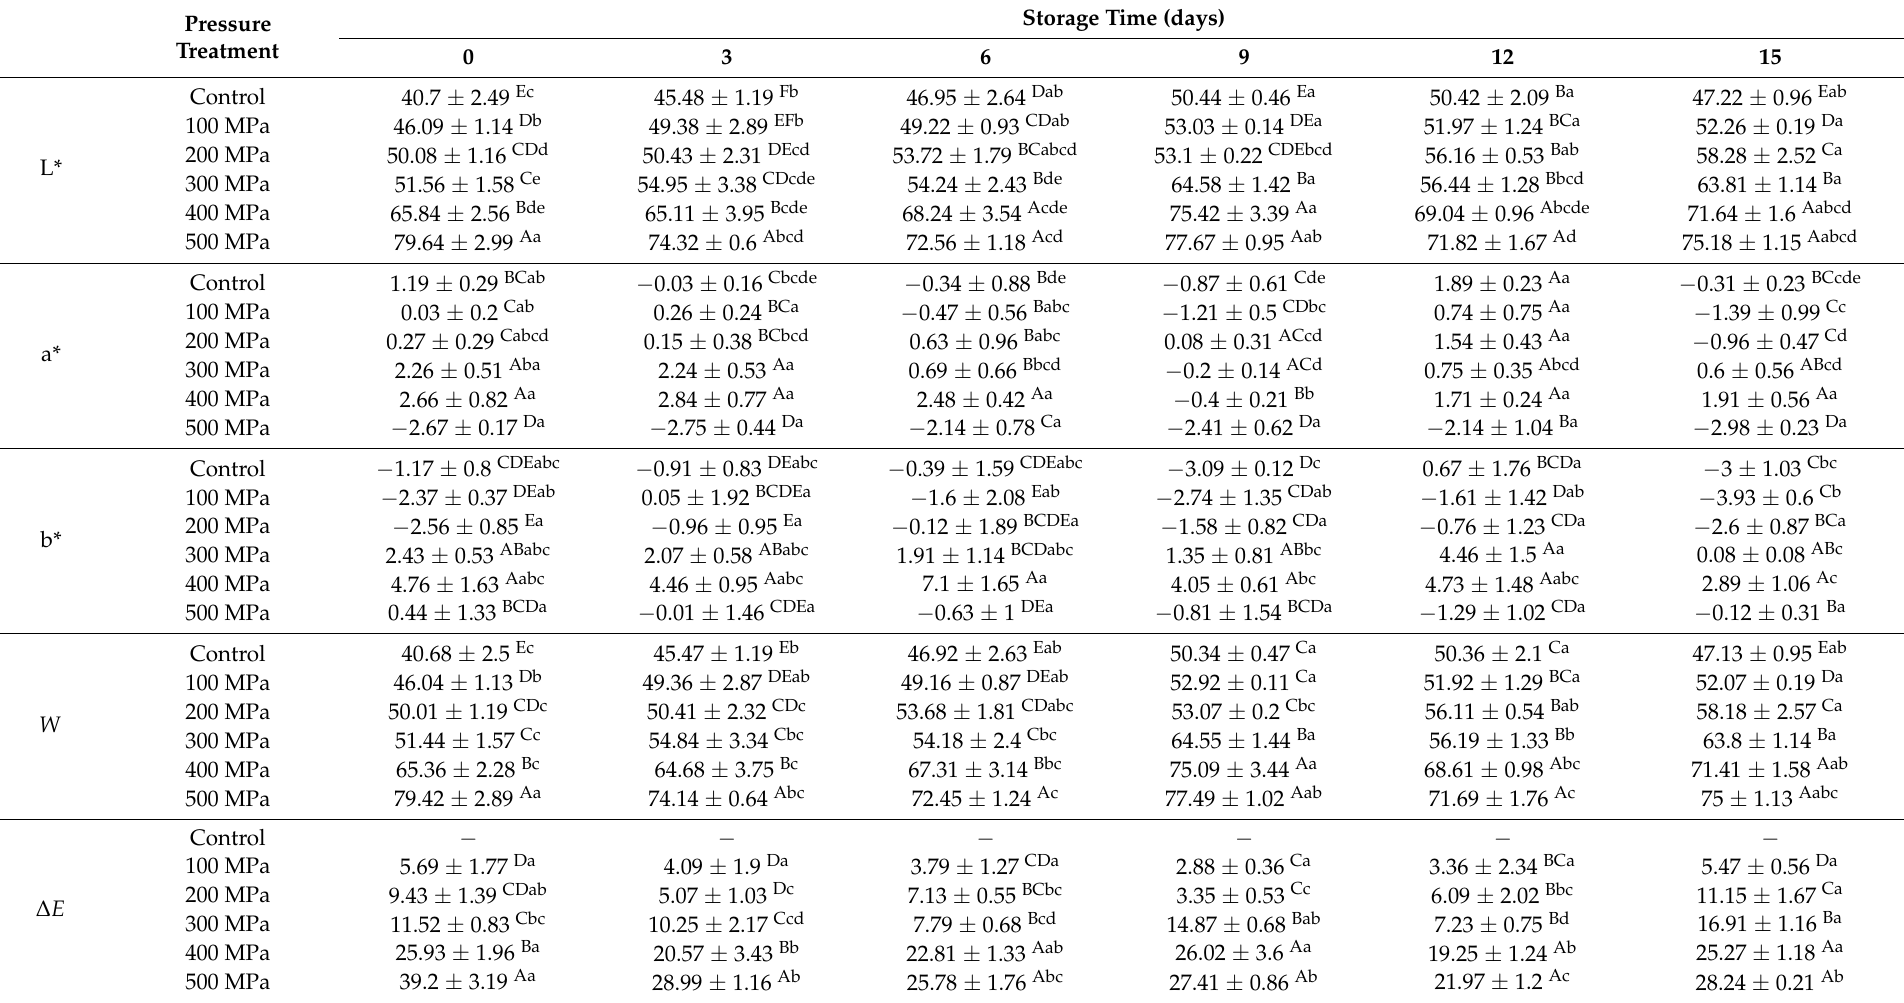
Table 1. Effects of UHP treatment on color changes of shrimp during